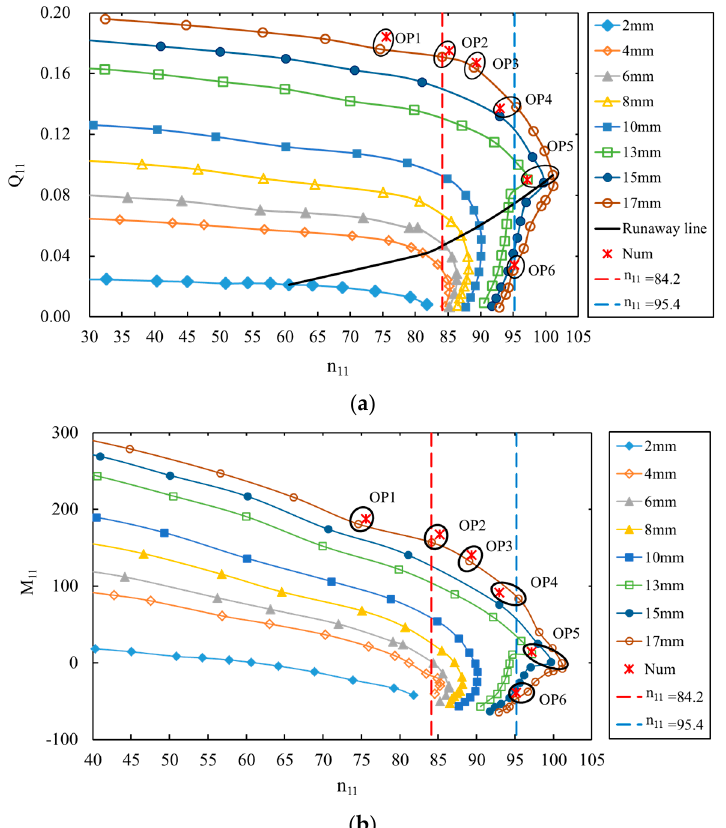
Figure 3. S-shaped curves at constant guide vane openings. ( a ) n M − characteristic curve. ( b ) n − M 11 11 11 11 characteristic